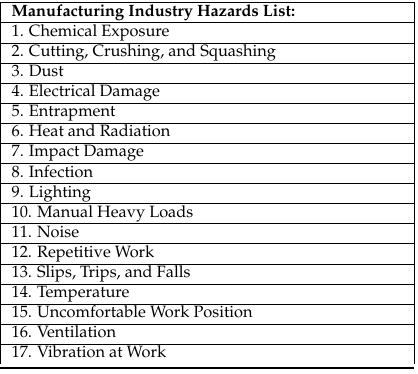
Figure 2. Manufacturing industry hazards list. Applicable hazards are identified as illustrated in Figure 5, see Section 4.3.1. This part of the analysis can be addressed by using a conventional risk management